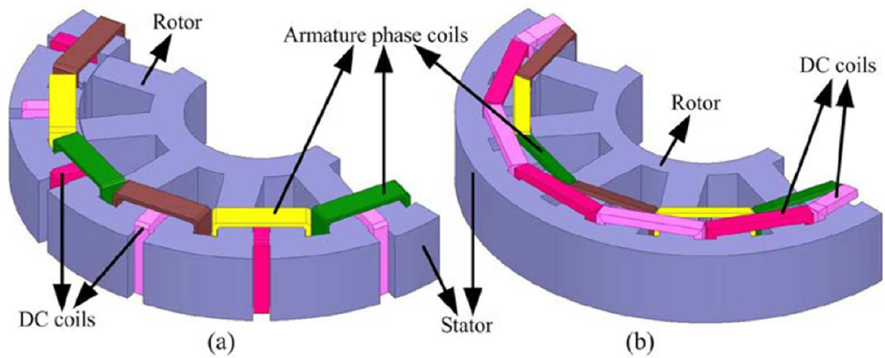
Figure 8. Presentation of the selected WF-FSM designs: ( a ) D-I and ( b ) D-II [107].